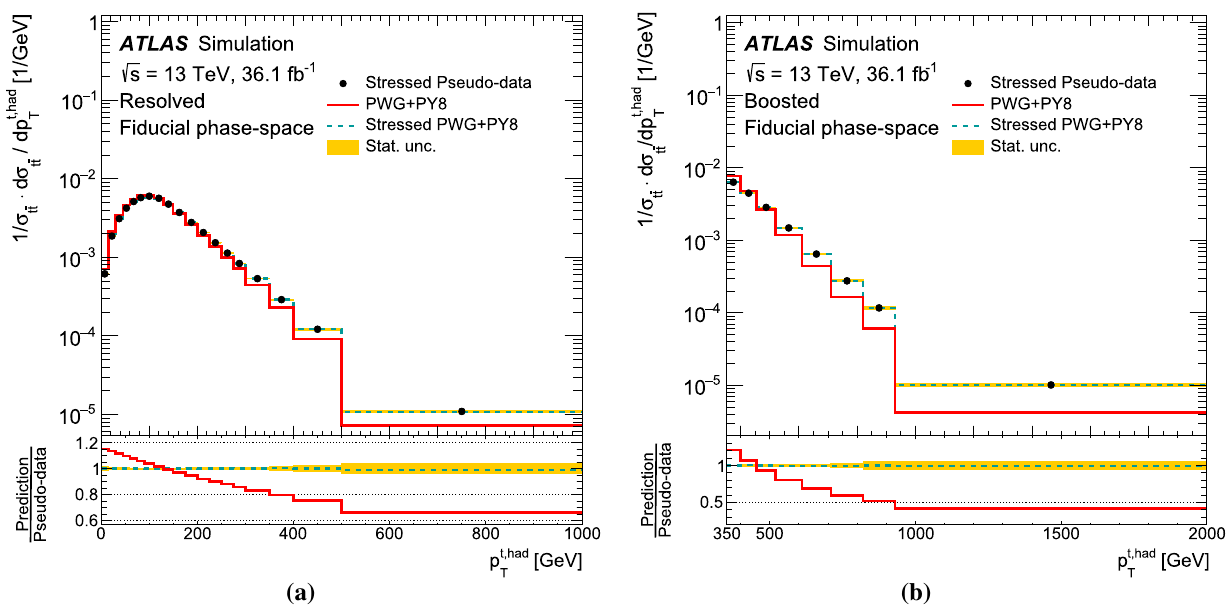
Fig. 17 Stress tests for the particle-level normalised differential cross- sections as a function of the p T of the hadronically decaying top in a the resolved and b the boosted topologies. The pseudo-data are obtained by reweighting the detector-level distributions obtained with Powheg + Pythia8 generator using a linear function of the particle- level p t , had andunfolded using the nominal corrections. The pseudo- T